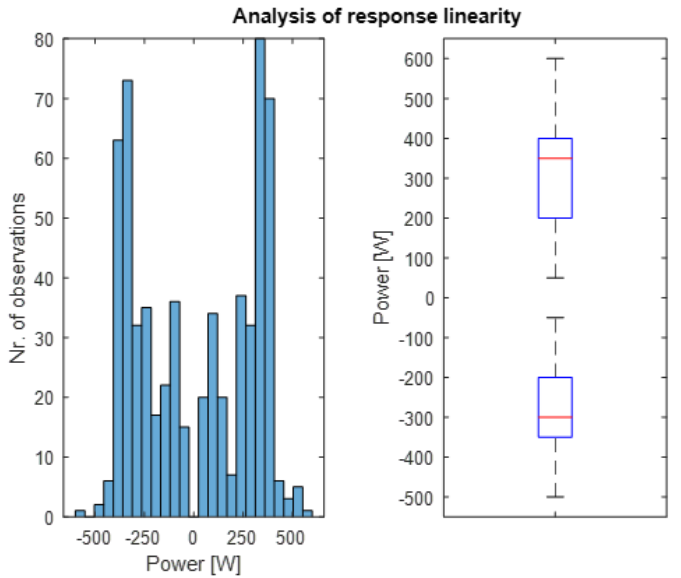
Figure 7. Distribution of the observed granularities in terms of absolute and percentage observations. For the boxplots, the blue boxes indicate 50% of the observations, whereas the median is in red. Upper and lower quartiles (25% of the data) are located within the vertical black lines.